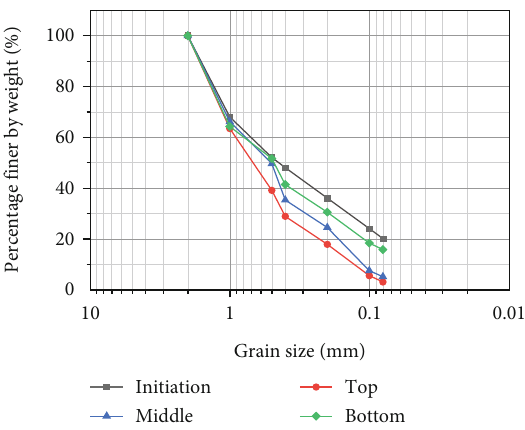
Figure 9: Test number 2 particle grading variation curves before and after seepage.